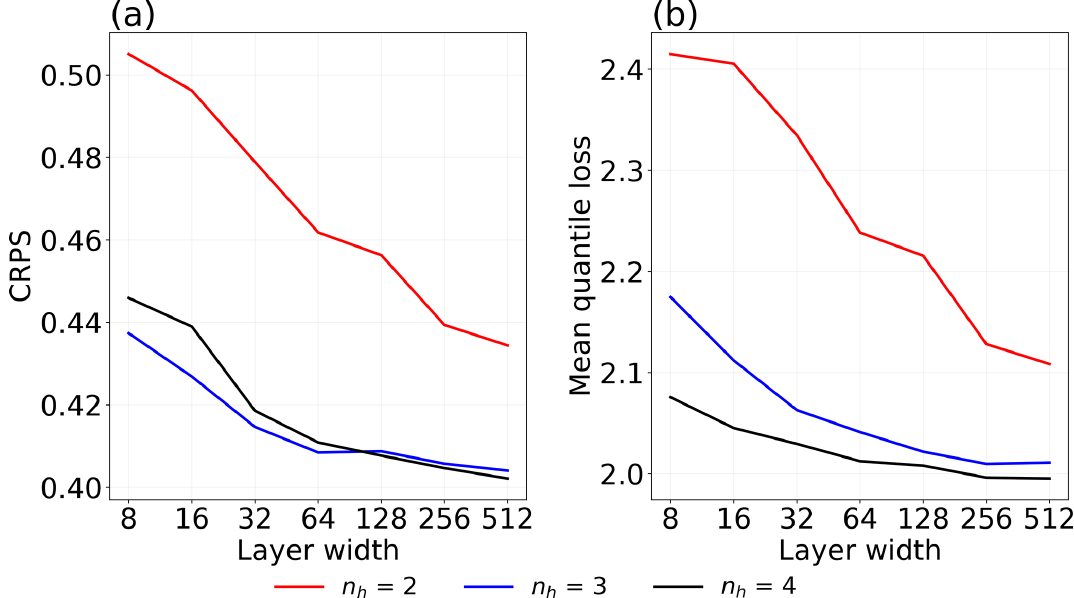
Figure B1. (a) CRPS and (b) mean quantile loss averaged over all predicted quantiles for different combinations of layer width and hidden layers ( n h ). The results are from QRNN-single applied to